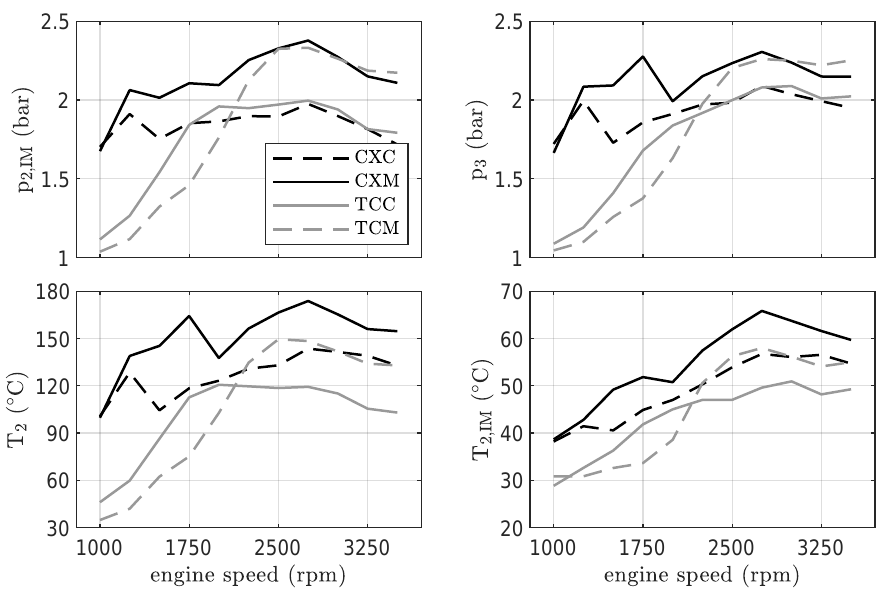
Figure 8. Pressures and temperatures during full-load